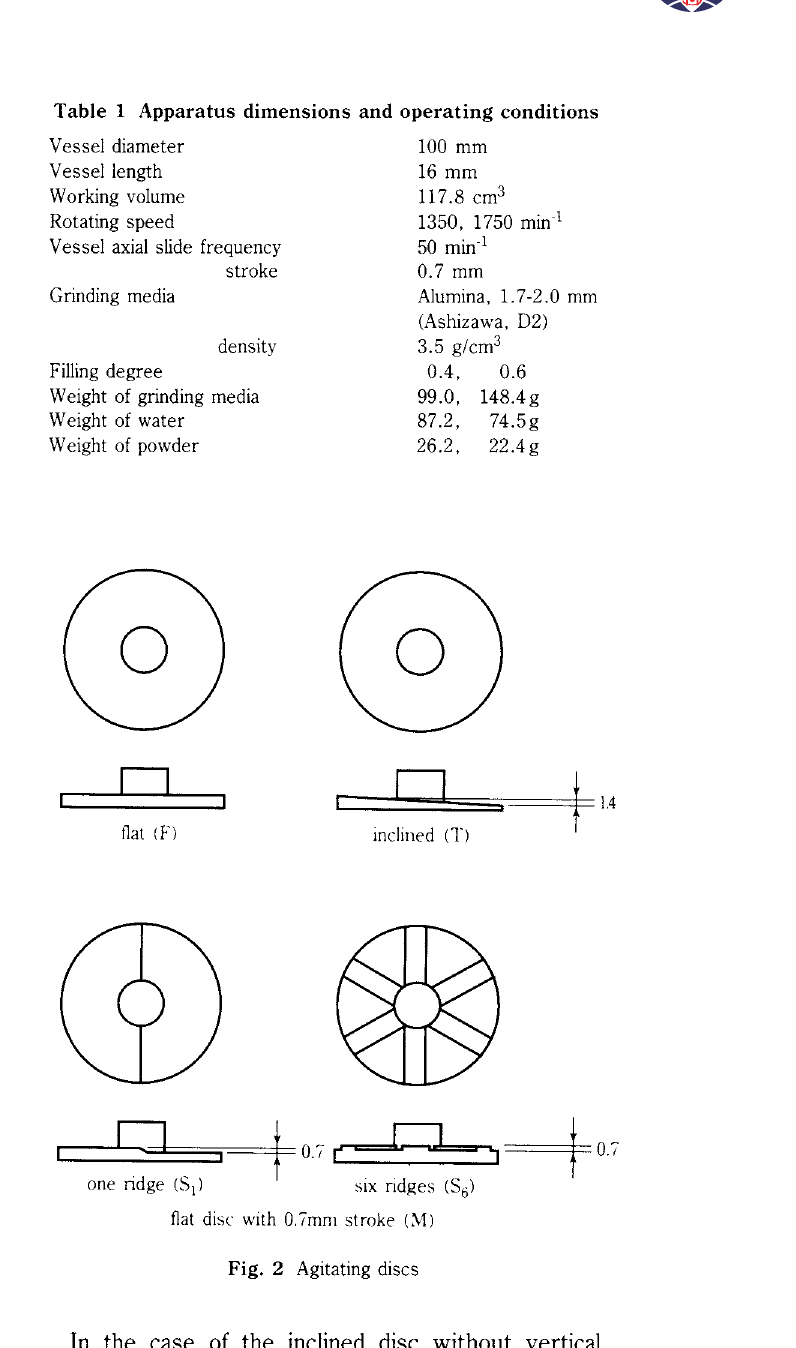
Table 1 Apparatus dimensions and operating